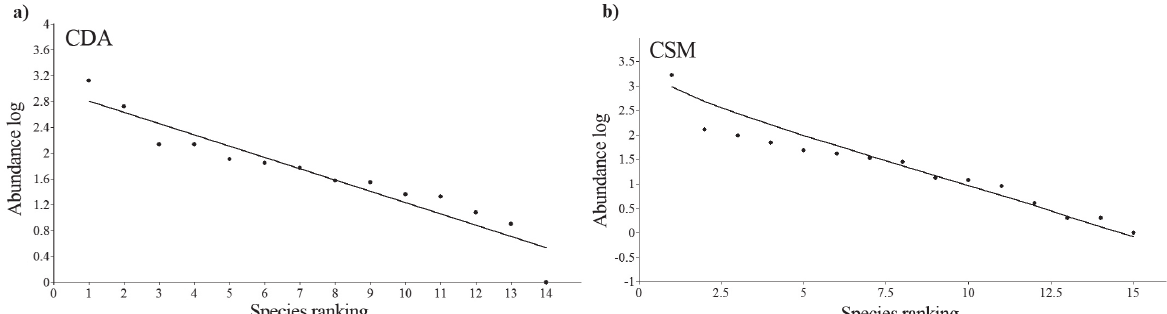
Figure 4 - Whittaker’s Graphs based on decrescent values of logarhythm of the abundance (dots) of anuran species recorded in the areas CDA ( a ) and CSM ( b ), located in the mid northern region of the state of Paraná, between September 2011 and March 2012, plotted with their respective significant theoretical curves (bold lines). CDA: better adjusted to the Geometric Series model (p = 9.9^-146). CSM: better adjusted to the Logarhythmic Series model (p =